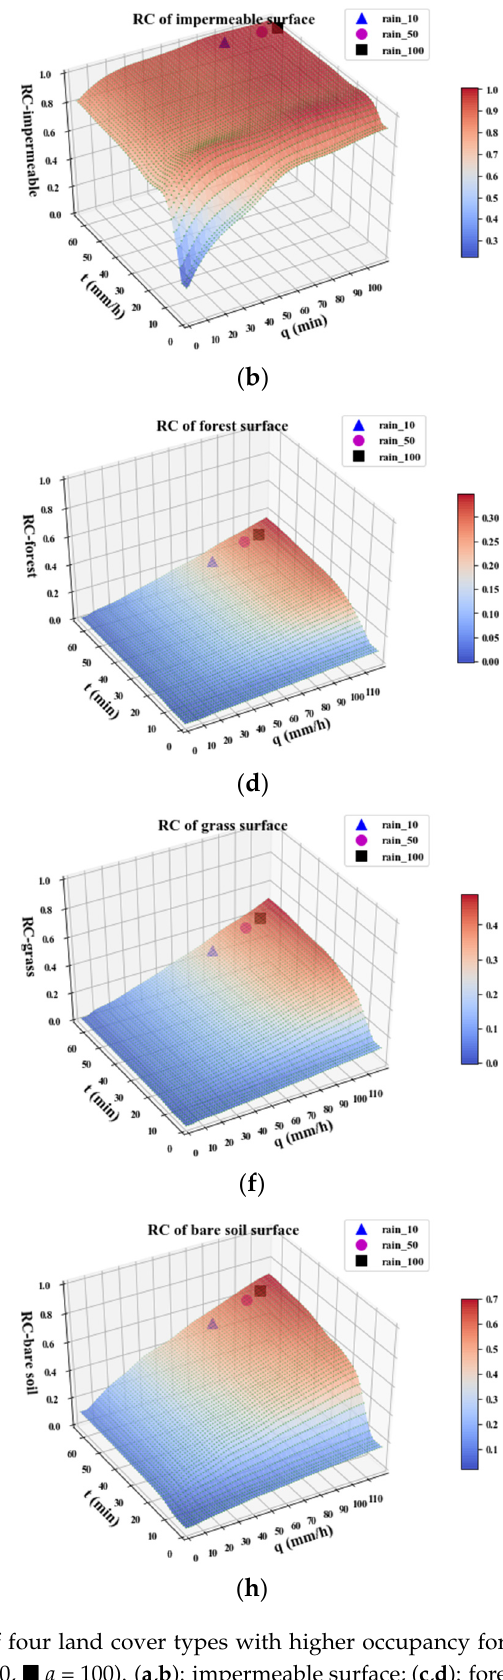
not considered here. The runoff coefficient of coniferous forests is calculated at 1.15 times